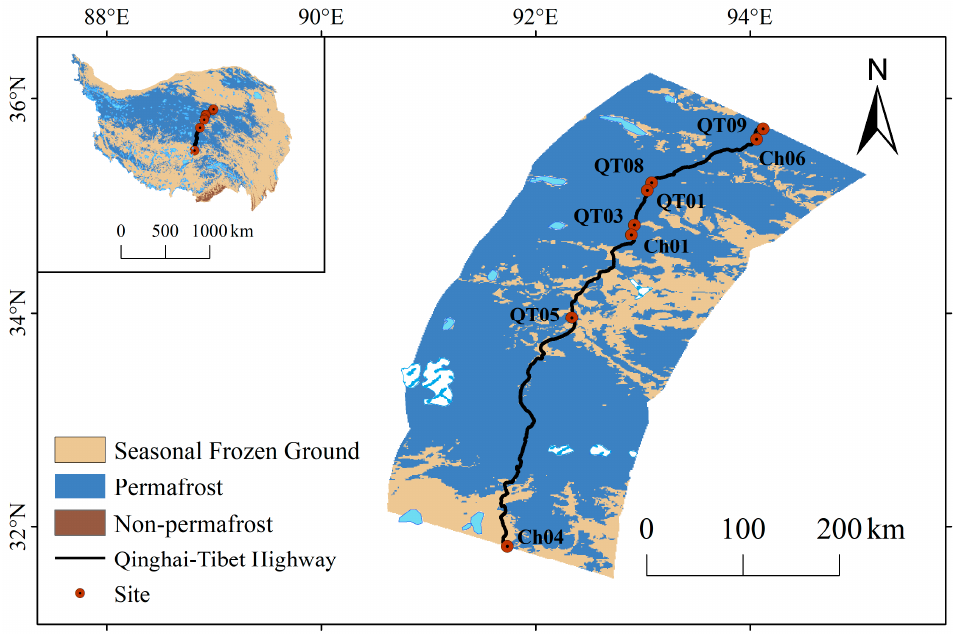
Figure 1. Location of the study area and monitoring sites (the spatial distribution of frozen ground types is derived from Zou et al., 2017 [8]).